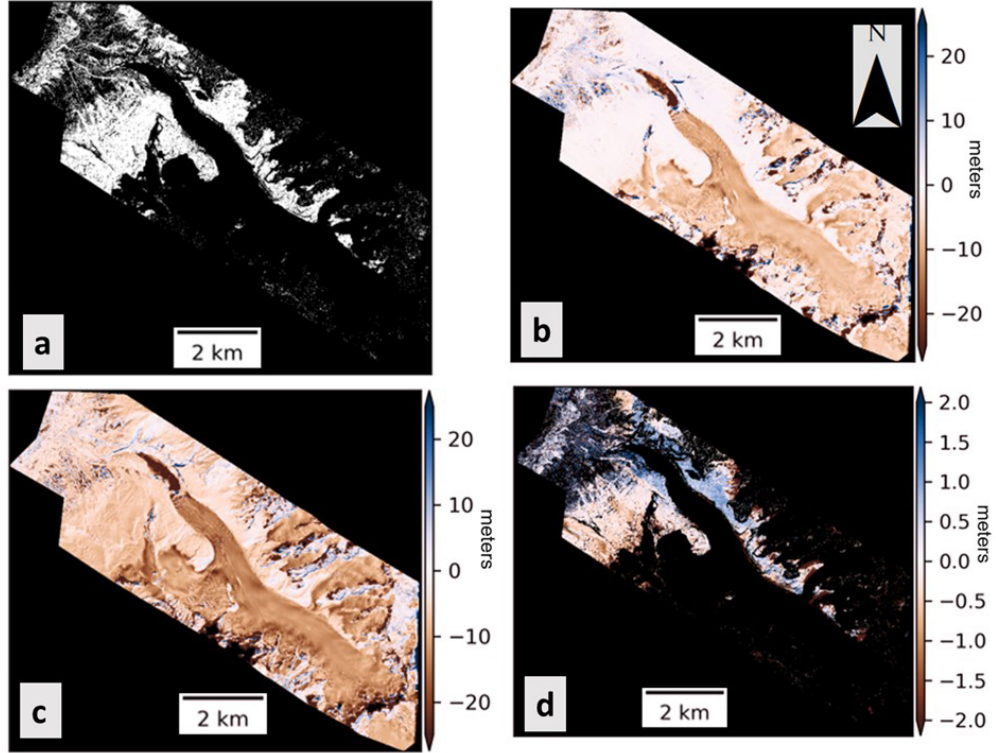
Figure 7. Stepwise Pleiades DEM accuracy assessment: (a) the surfaces used for coregistration, (b) elevation difference before coregistration, (c) elevation difference after coregistration considering all areas and (d) elevation difference after coregistration considering only the stable areas.